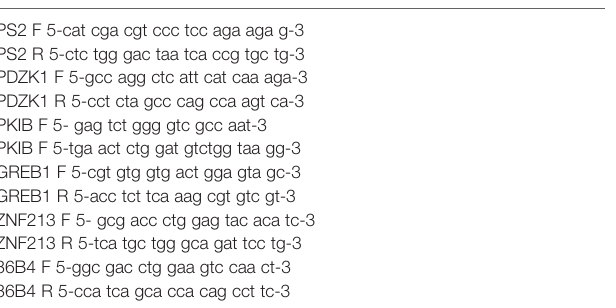
TABLE 1 | Primer sequence information for